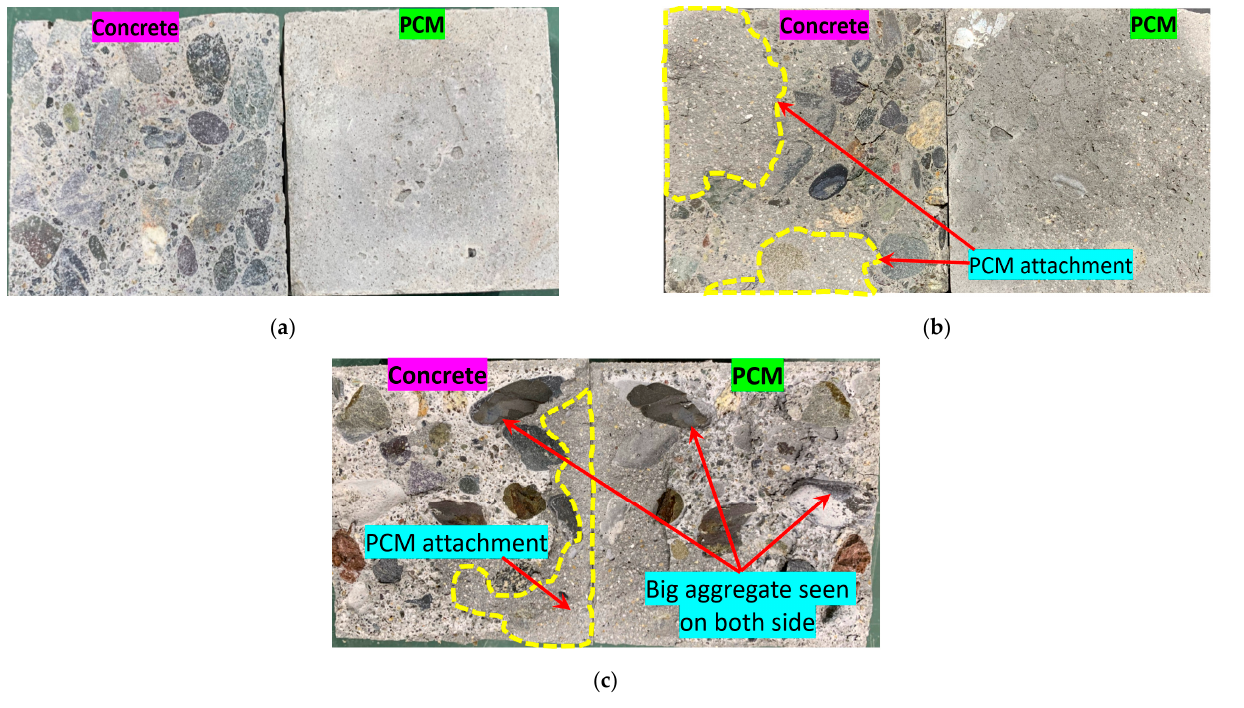
Figure 11. Sample fracture surfaces of the composite specimens (without-primer cases). ( a )